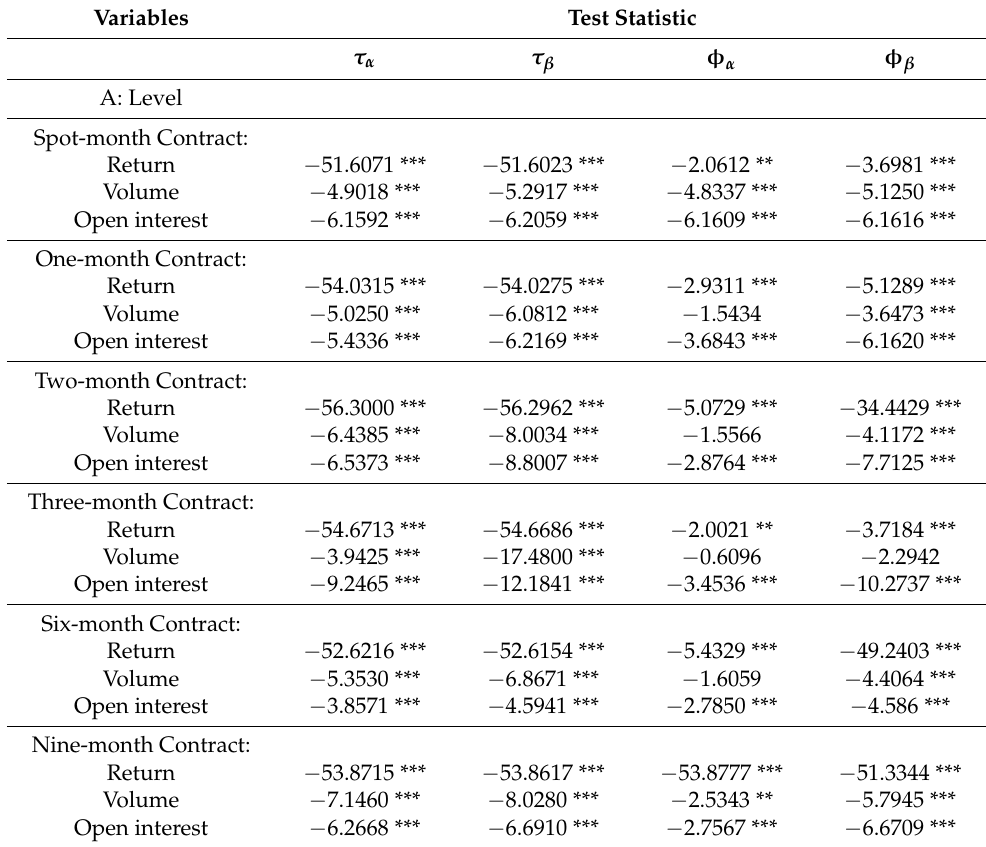
Table 2. ADF and ERS unit